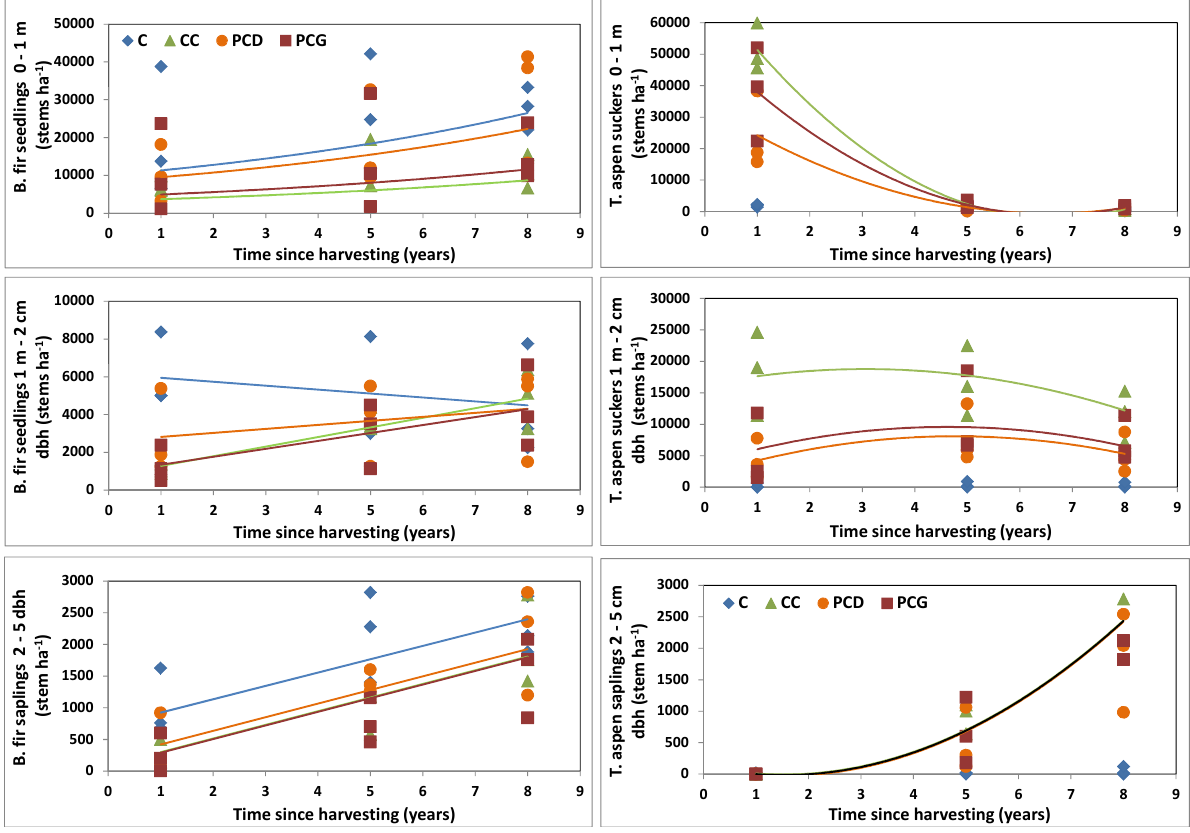
Figure 3. Balsam fir and trembling aspen regeneration densities in mixed boreal stands as a function of harvesting treatment and time since harvesting . Points are average observed values over experimental blocks. Lines are predicted values according to models (see Table 2 for model specifications). Control stand values were not included in statistical models for trembling aspen regeneration, but observed values are displayed in figures. C: control